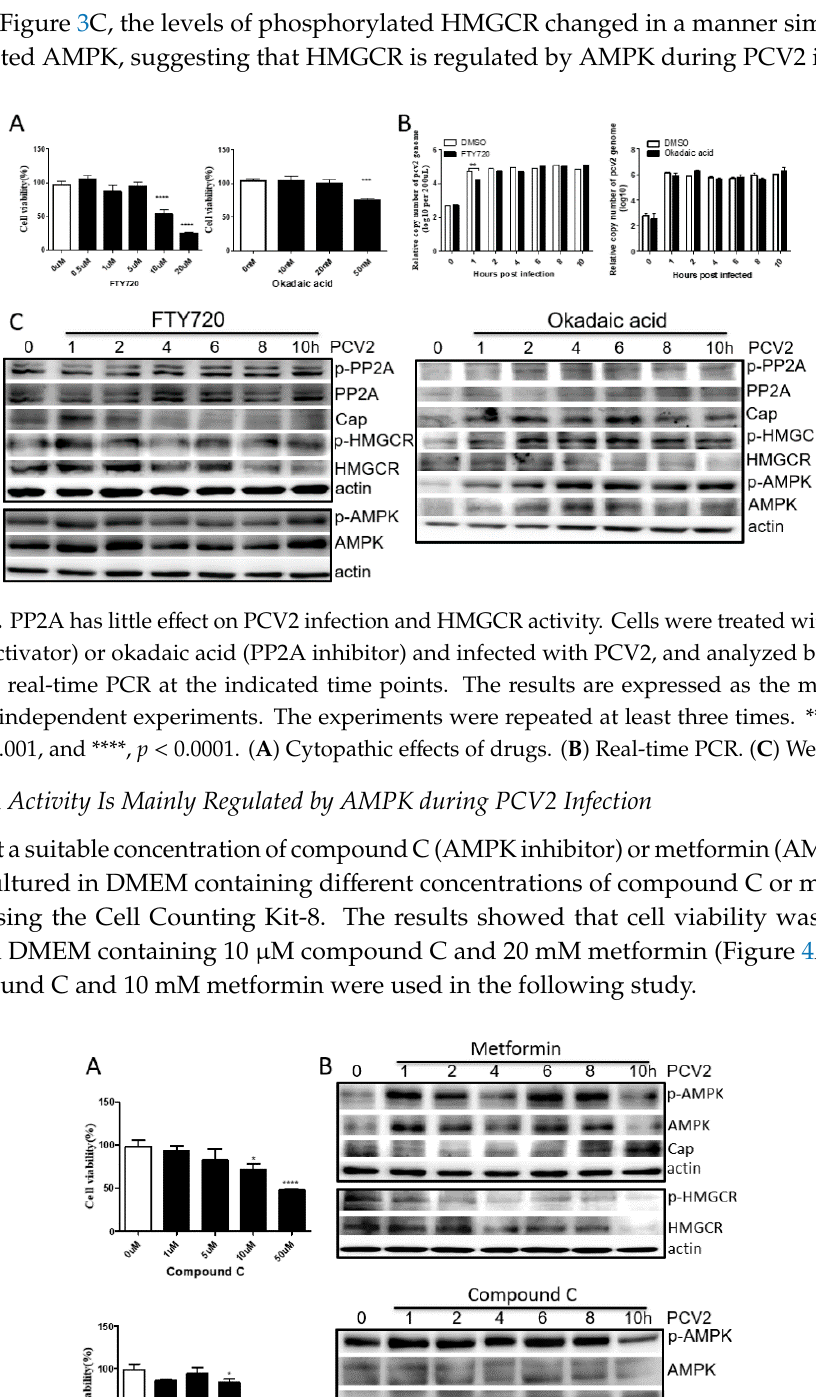
( F ) Figure 5. Construction scheme of the plasmids used in this study. The Cap and Rep genes of PCV2 were cloned into Lenti-CAG-WPRE by Mlu I and Age I to generate recombinant expression plasmids